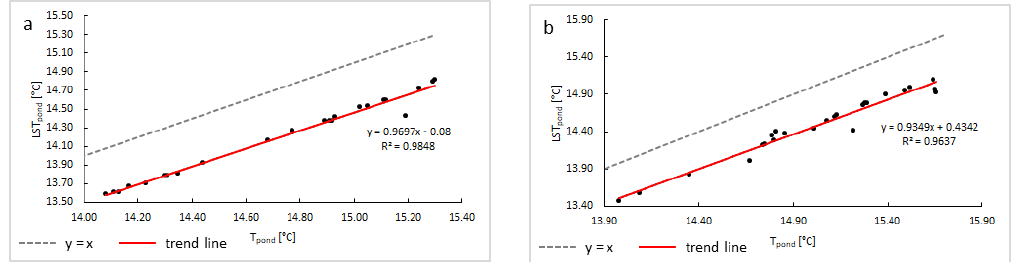
Figure 10. Correlation of the retrieved pond temperature ( LST pond ) and measured pond temperature ( T pond ), with flight 1 ( a ) on the left and flight 3 ( b ) on the right 11 April 2018, 13:32 and 16:32 CET, respectively).